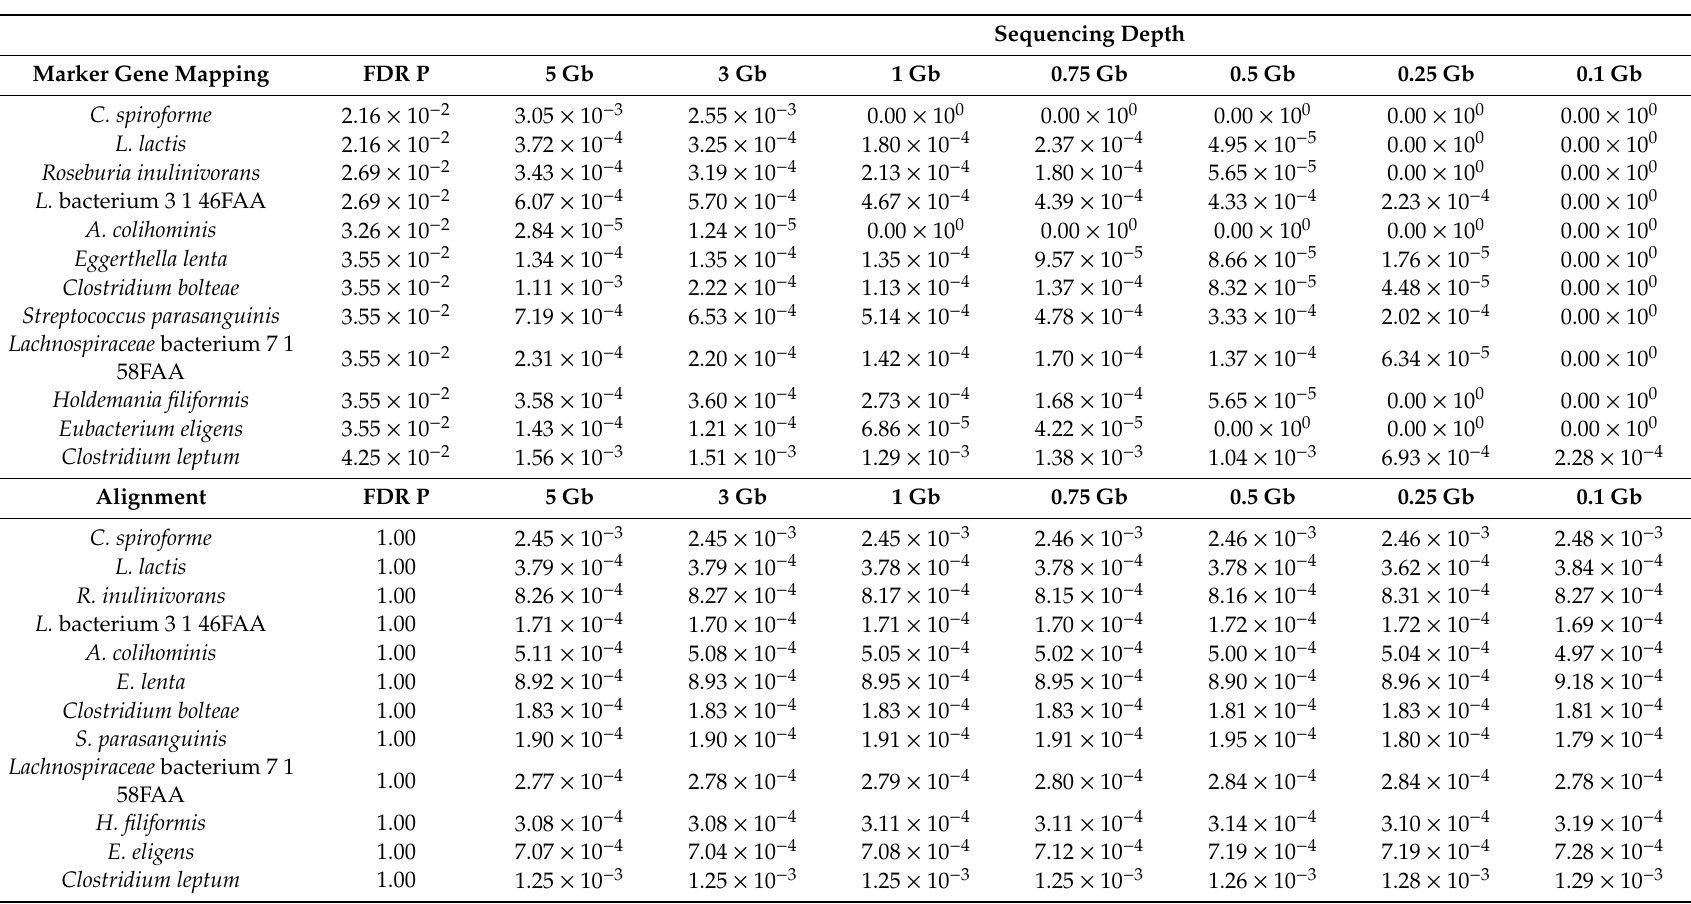
Table 1. Group significance analyses (Kruskal–Wallis) of ten stool samples at various SMS sequencing depths and annotated using a marker gene-mapping- and alignment-based approaches. Table shows the mean relative abundance (%) of bacterial species that are significantly di ff erent across the various sequencing depths when considering FDR-adjusted p -values (FDR